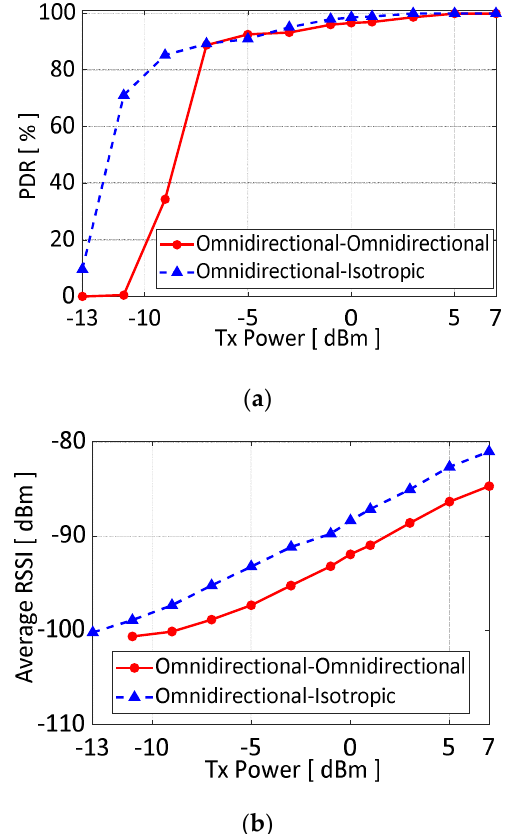
ff erent floor levels of the